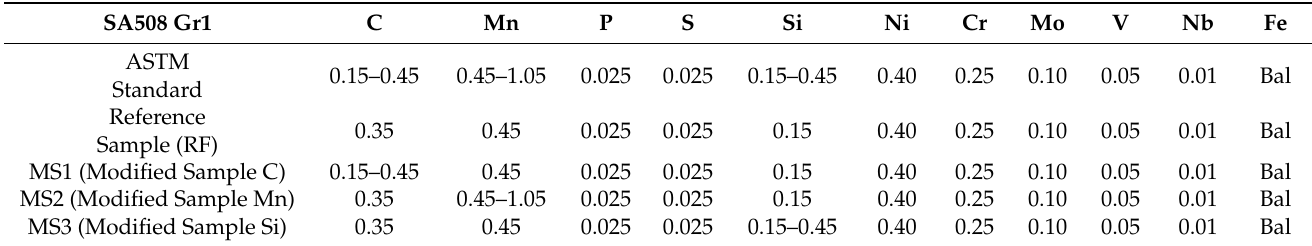
Table 1. Chemical compositions in SA508 Gr 1(wt.%)